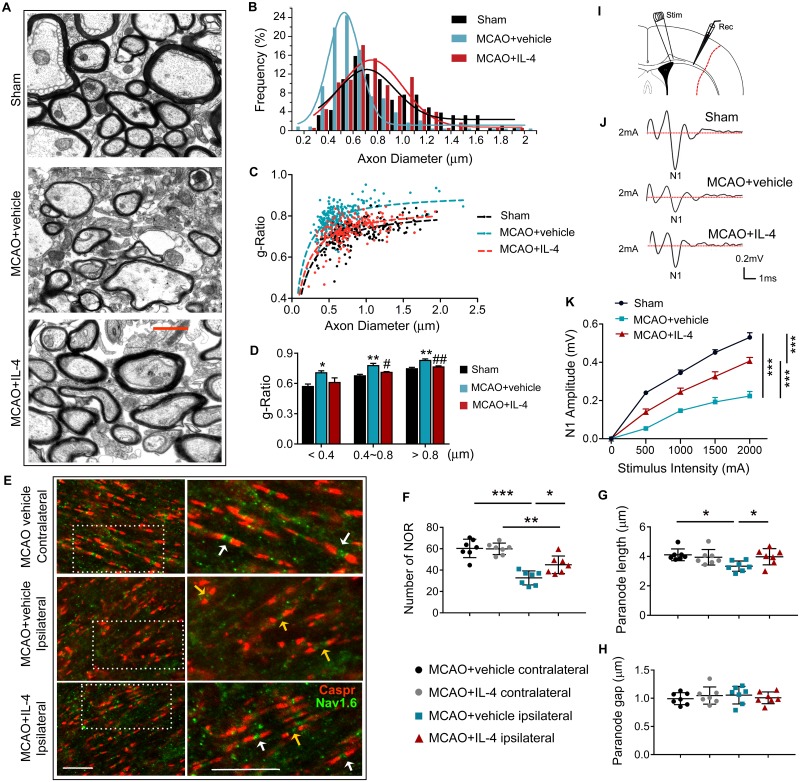
IL-4 post-treatment improves the anatomical integrity and physiological function of myelinated fibers after stroke.(A-D) TEM ultrastructural analyses of myelin integrity in the EC of sham, MCAO+vehicle, and MCAO+IL-4 groups at 35 d after surgery. (A) Representative TEM images show thinner myelin sheaths at a demyelination site in the EC after stroke. IL-4 treatment increased myelin thickness. Scale bar: 1 μm. (B) Frequency histograms of axon diameter. (C) Scatter plots of g-ratio as a function of axon diameter in sham mice or stroke mice treated with vehicle or IL-4. (D) The g-ratio of myelinated axons with respect to axon diameter at 0.4-μm intervals for sham mice or stroke mice treated with vehicle or IL-4. n = 3/group. *p < 0.05, **p < 0.01 versus sham; #p < 0.05, ##p < 0.01 versus MCAO + vehicle. One-way ANOVA followed by Bonferroni post hoc. (E-H) Caspr and NaV1.6 immunostaining in the EC of MCAO+vehicle and MCAO+IL-4 groups at 35 d after surgery. (E) Representative images of Caspr (red) and NaV1.6 (green) immunostaining. Scale bar: 10 μm. (F) Quantification of numbers of NORs. (G) Quantification of the paranode (Caspr+) length. (H) The length of the paranode gap was quantified as the length between a pair of Caspr+ sites. N = 7/group. *p < 0.05, **p < 0.01, ***p < 0.001. One-way ANOVA followed by Bonferroni post hoc. (I-K) Electrophysiological analyses of brain slices prepared from sham, MCAO+vehicle, and MCAO+IL-4 mice 35 d after MCAO. (I) Schematic illustration of the position of the stimulating (“Stim”) and recording (“Rec”) electrodes for CAP measurements in CC/EC. (J) Representative curves of CAPs in myelinated N1 fibers. (K) Quantification of amplitude of evoked CAPs in myelinated N1 fibers. N = 6/group. ***p < 0.001. Two-way ANOVA repeated measures followed by Bonferroni post hoc. Data associated with this figure can be found in the supplemental data file (S1 Data). CAP, compound action potential; Caspr, contactin-associated protein; CC, corpus callosum; EC, external capsule: IL-4, interleukin-4; MCAO, middle cerebral artery occlusion; NOR, nodes of Ranvier; TEM, transmission electron microscopy.